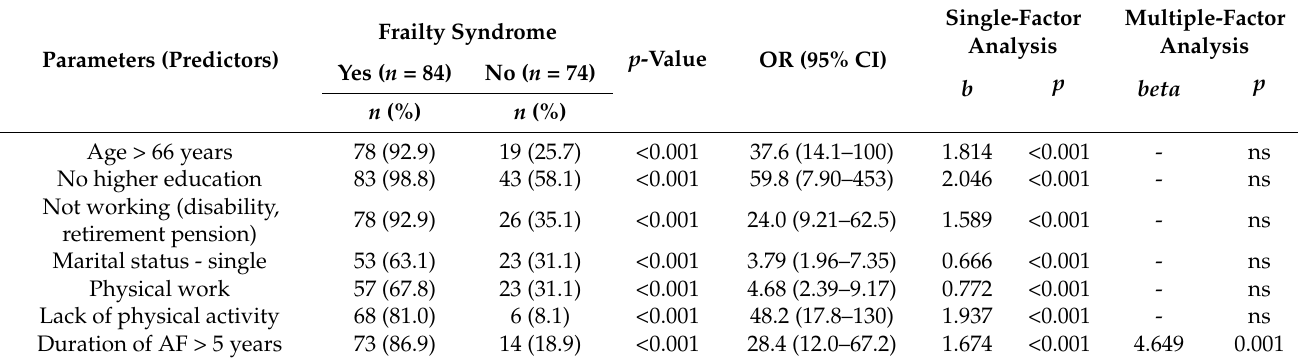
Table 6. Frailty syndrome (FS) predictors in patients with atrial fibrillation (AF) and odds ratio (OR) and logistic regression coefficients (b and beta) for FS and the sociodemographic and clinical characteristics